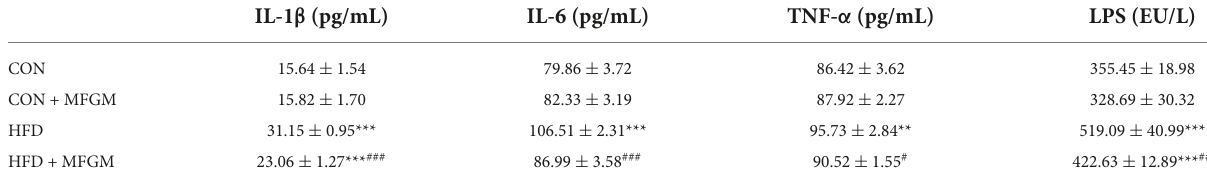
TABLE 1 Maternal supplementation with milk fat globule membrane during pregnancy and lactation alleviated serum levels of inflammatory factors in weaned offspring from HFD